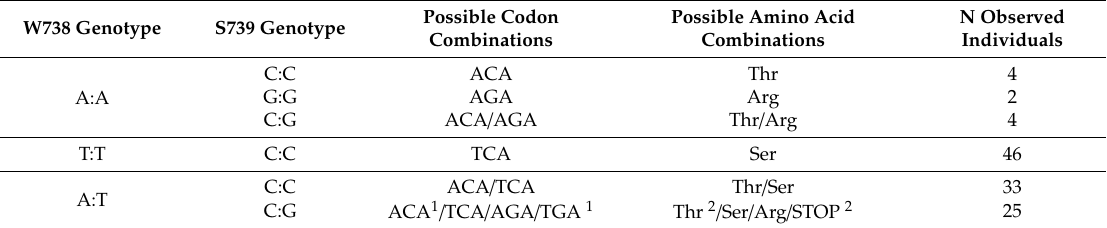
Table 2. Observed genotypic combinations between the VviUCC1 SNPs W738 and S739 in 114 grapevine